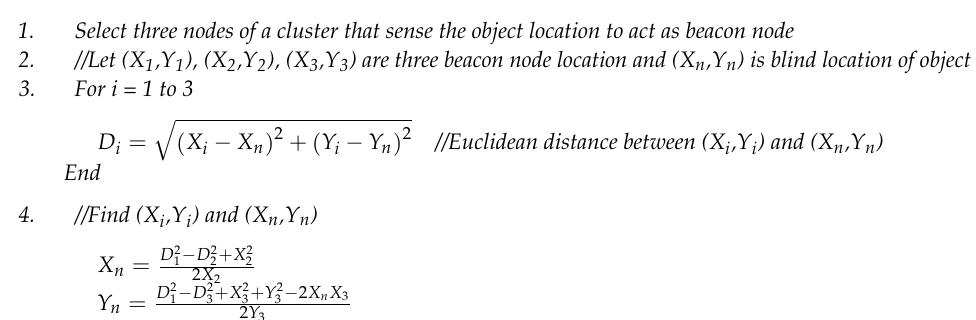
Algorithm 8 : Trilateration-algorithm-based object